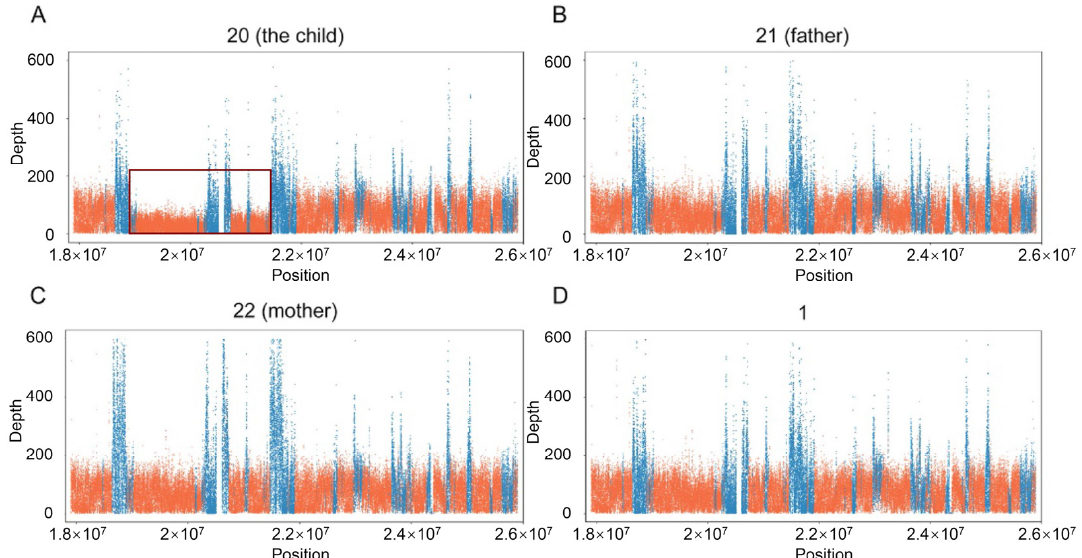
Figure 1. Depth of several samples with a 100 bp sliding window. ( A ) The child in the nuclear family. The red box indicates the deletion of LCRA-D. ( B , C ) The healthy parents in the nuclear family. ( D ) Patient #1. Bases labeled as N in the reference genome are represented by blue dots, while red dots indicate bases located in other regions.